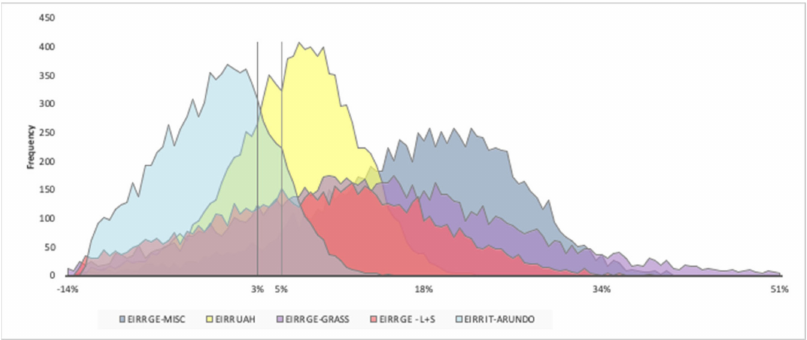
Figure 2. Overlay chart of financial internal rate of return (FIRR) of the selected investments.